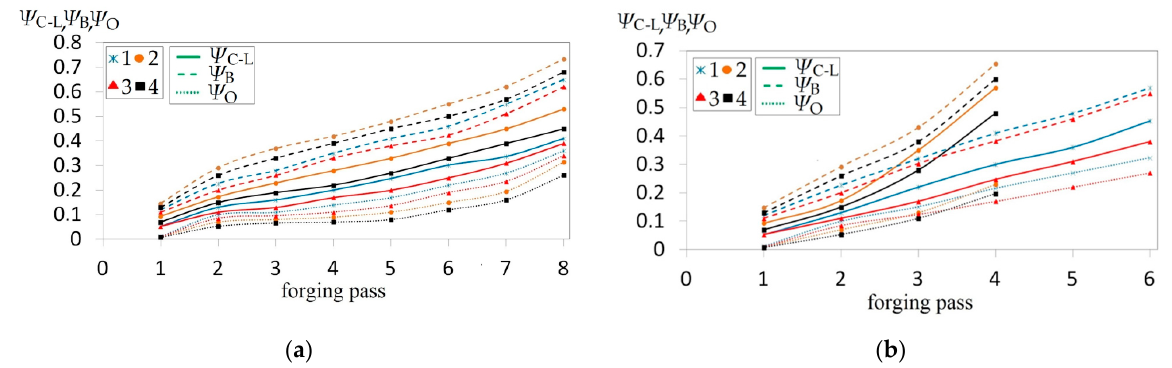
Figure 21. Influence exerted by of different passes upon the damage factors: Cockcroft and Latham ( Ψ C-L ), Oyane et al. ( Ψ O ), and Brozzo et al. ( Ψ B ) in the axial zone in the course of cogging of the forging with a concave cross-section in flat anvils ( a ) and in V-shaped anvils ( b ) for different angles and reduction ratio: 1— ε c = 0.22, α c = 135°; 2— ε c = 0.51, α c = 135°; 3— ε c = 0.22, α c = 165°; 4— ε c = 0.51, α c = 165°.